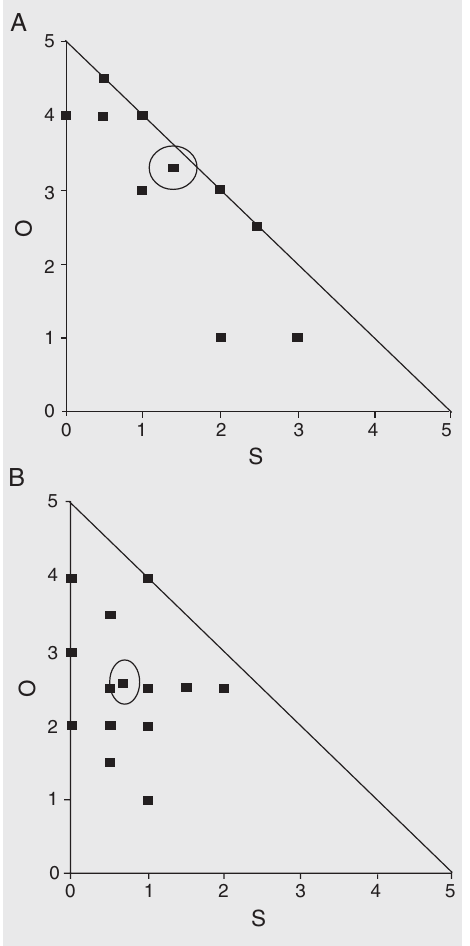
Figure 3. Diagrams of oligoden- drocyte (O) versus Schwann cell (S) remyelination scores in non- diabetic (A) and diabetic (B) rats 31 days post-lesioning. The ar- eas within circles represent mean ± 2 SEM and are consid- ered as domains that represent an average of repair. Non-over- lapping repair domains indicate significantly different results. The majority of axons are remy- elinated by